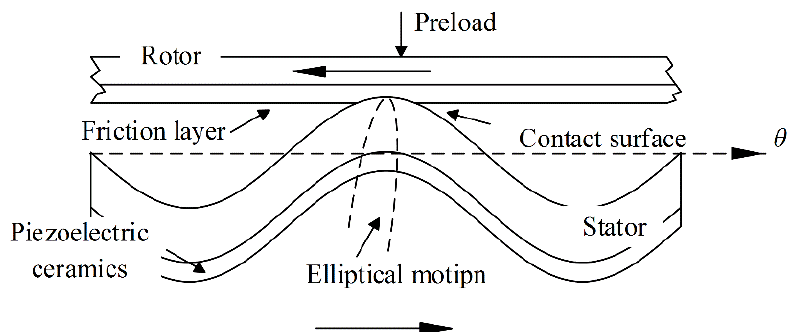
Figure 1. Contact surface between stator and rotor. For the rotor, the friction layer is pressed on the surface of the stator by preloading, and the rotor is driven by friction force, which is generated through the elliptical motions of the particles on the stator surface, excited by the traveling wave. The driving torque T d generated by the circumferential friction force F θ can be expressed as [22]: